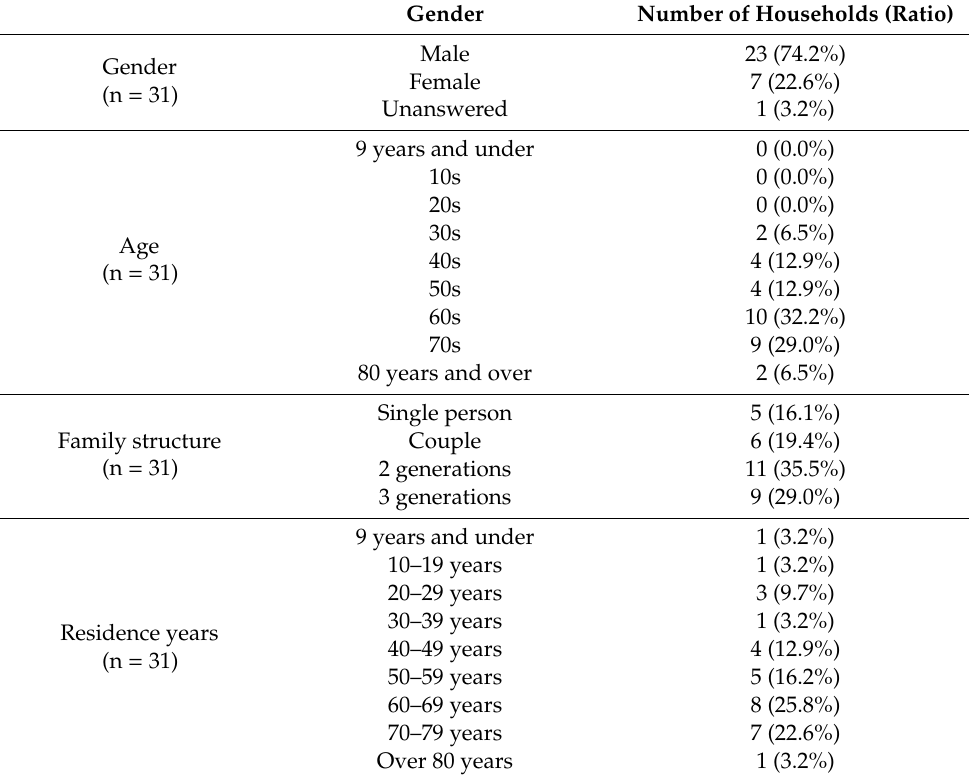
Table A1. Respondent attribute (n =